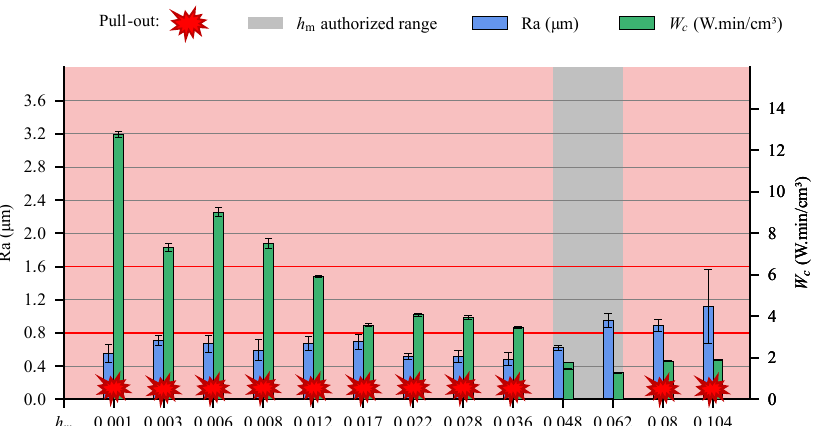
Figure 24. Evolution of the specific cutting energy (W · min/cm 3 ) and Ra (µm) of the universal tool for different h m (mm) with v c = 270 m/min, a p = 3 mm and a e = 0.5